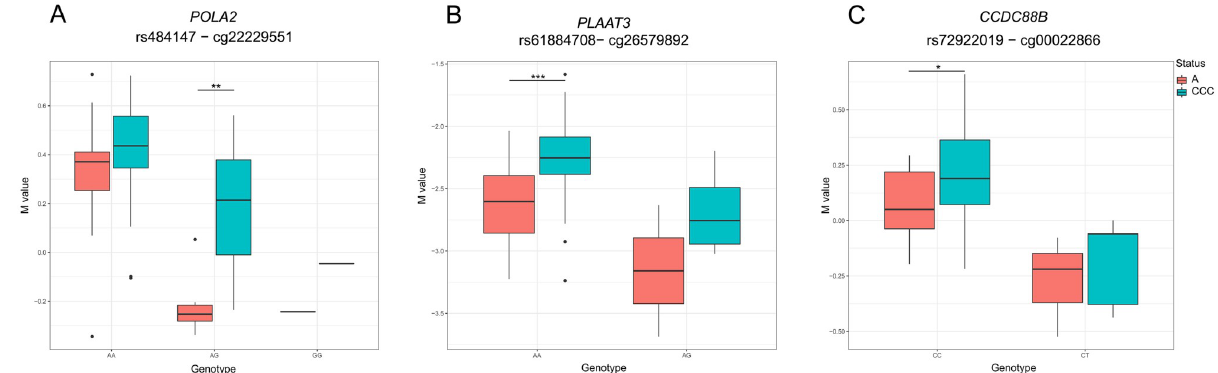
Fig 2. Box plots of three of the most interesting genes comparing DNAm levels between chronic Chagas cardiomyopathy patients (CCC) and asymptomatic individuals (A). Comparison of individuals’ SNP genotypes and CpGs Mvalues for the most interesting mQTL genes that also showed differences in methylation patterns in cases and controls. Significant differences between genotypes are marked with symbols according to their level of significance calculated with an ANOVA test ( � p-value � 0.05; �� p-value � 0.01; ��� p-value �